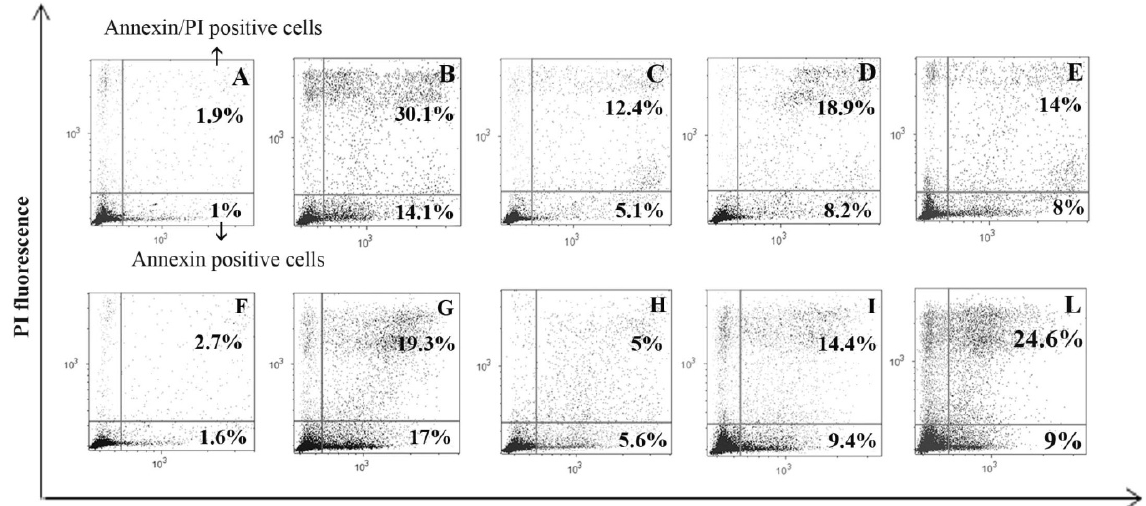
Figure 5. Annexin V/PI dot plots in control condition ( A ), MEL alone ( F ), H staurosporine ( G )-treated cells. In ( C ) and ( H ), dot plots are relative to MEL administration O and staurosporine respectively. Dot plots of caspase-9, -3 inhibitor pre-treatment before H 2 2 before apoptosis induction appear in ( D – E) and ( I – L